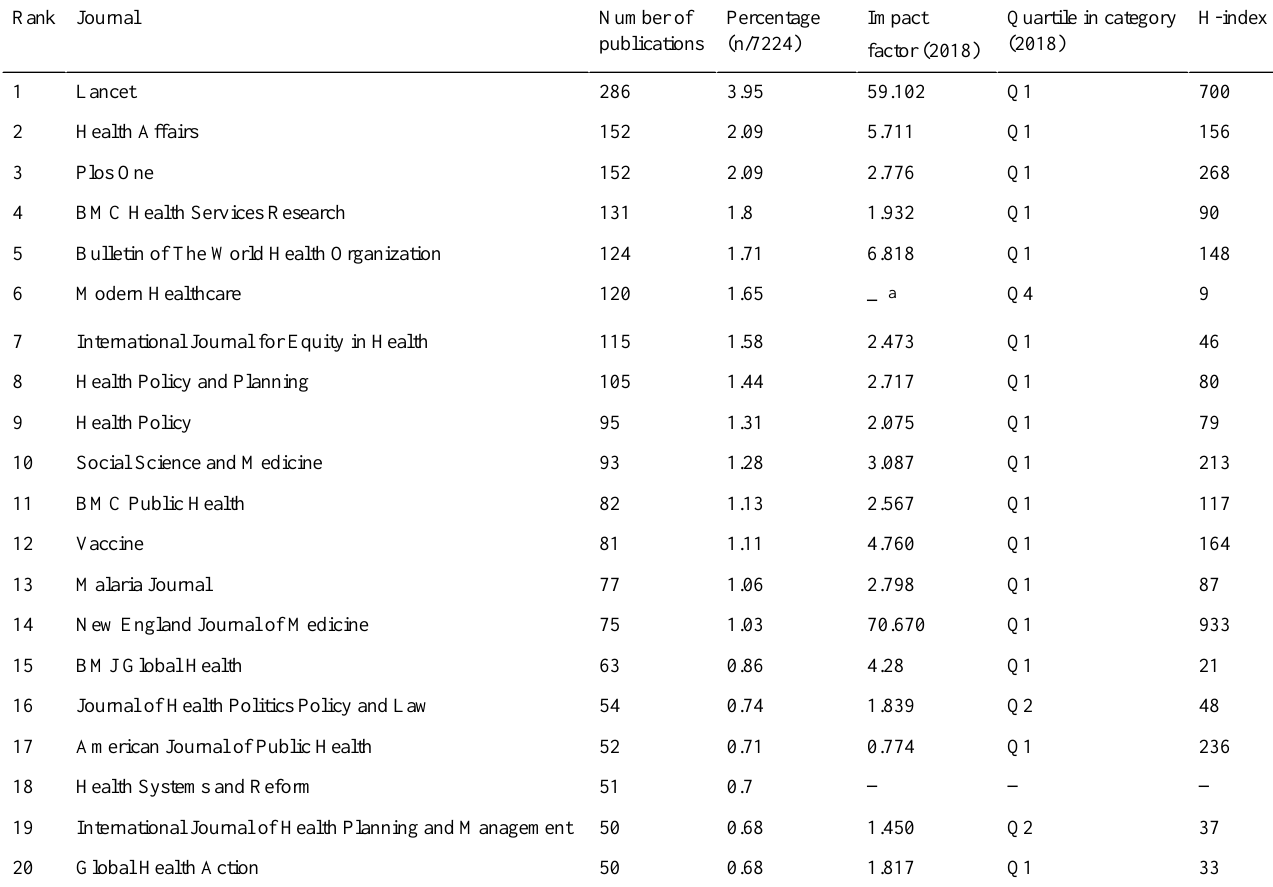
Table 3. Journals with the highest number of articles related to universal health